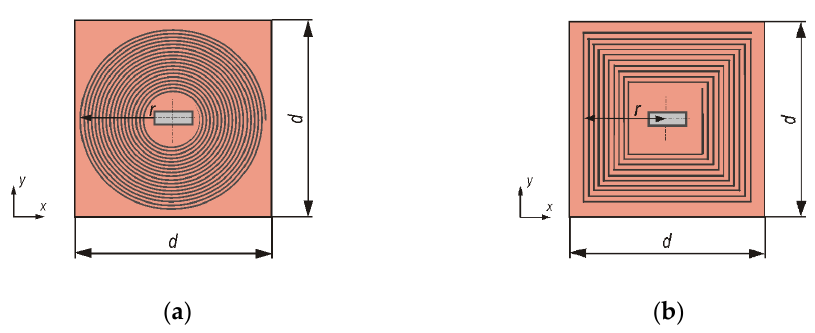
Figure 2. Two types of modelled coils: ( a ) circular, ( b ) square. Additionally, the influence of the winding direction on the parameters of the system was considered. The system with the transmitting-receiving surface composed of coils wound in the same direction is called the periodic system (Figure 3a,c).